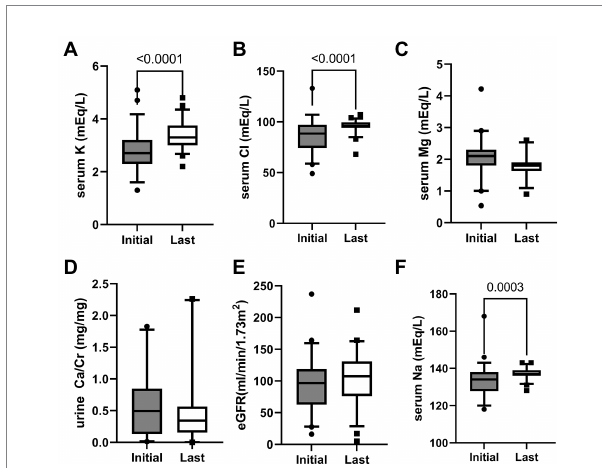
FIGURE 1 Chemistry after median 8 years follow-up. Box plots showing the quartiles, the 5th and 95th percentiles (whiskers) and extreme values. p -value is indicated on the graph for serum sodium, potassium, chloride, magnesium, estimated glomerular filtration rate (eGFR), and urine calcium/creatinine